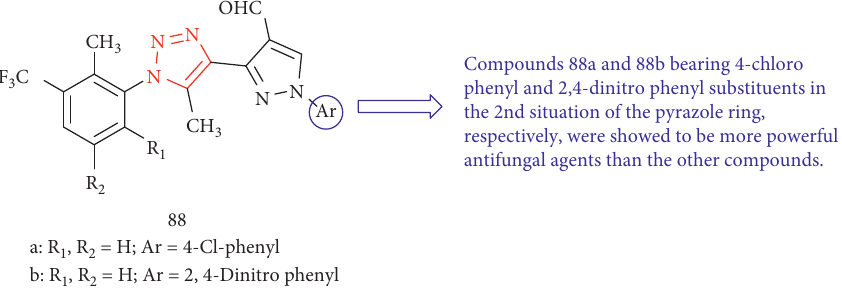
Figure 38: Chemical structure of new 1,2,3-triazolyl pyrazole derivatives.